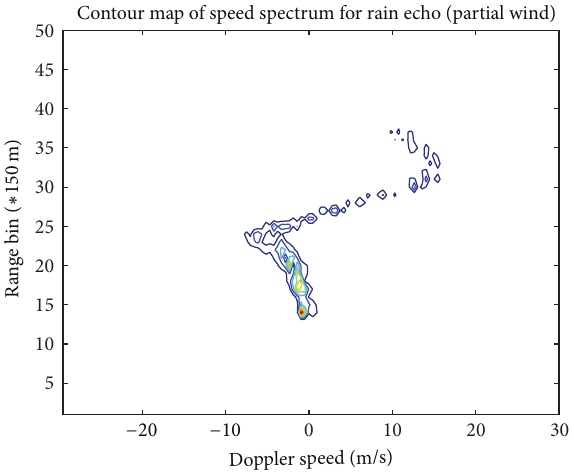
Figure 9: Rain Echo Spectrum Distribution of asymmetric wind field for partial wind (Contour